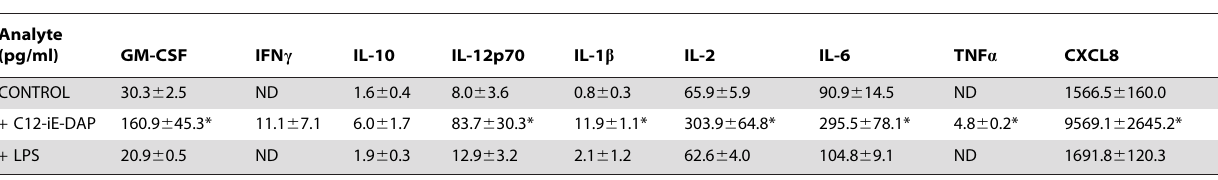
Table 1. MSD analysis of cytokine (pg/ml) release from hESC-EC.